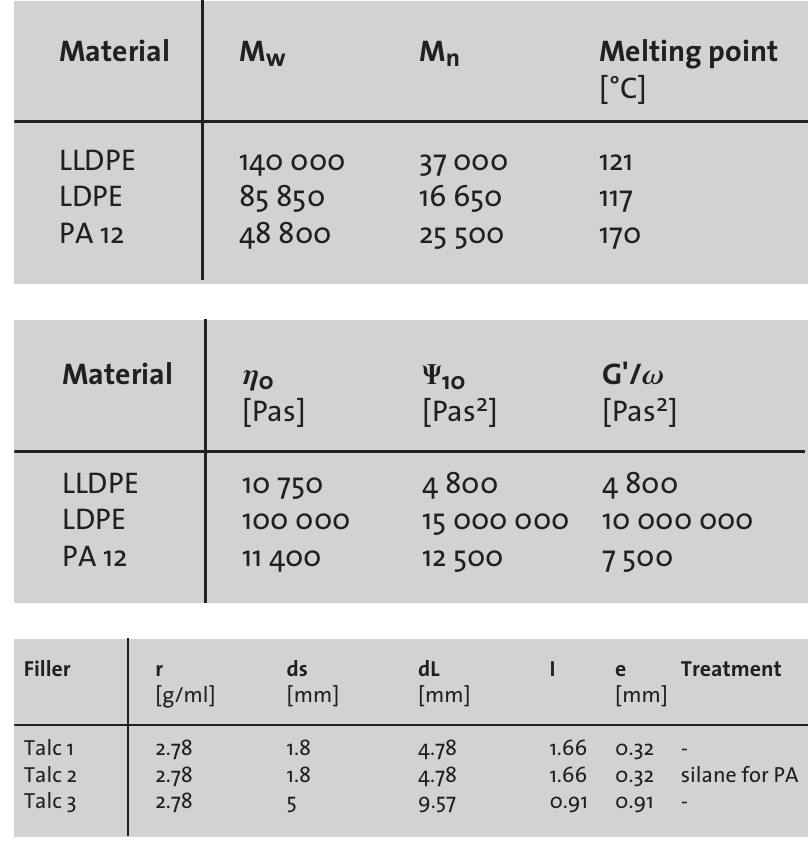
Table 1 (above): Polymer characteristics. Table 2 (middle): Rheological characteristics of pure polymers at 195˚C. Table 3 (below): filler